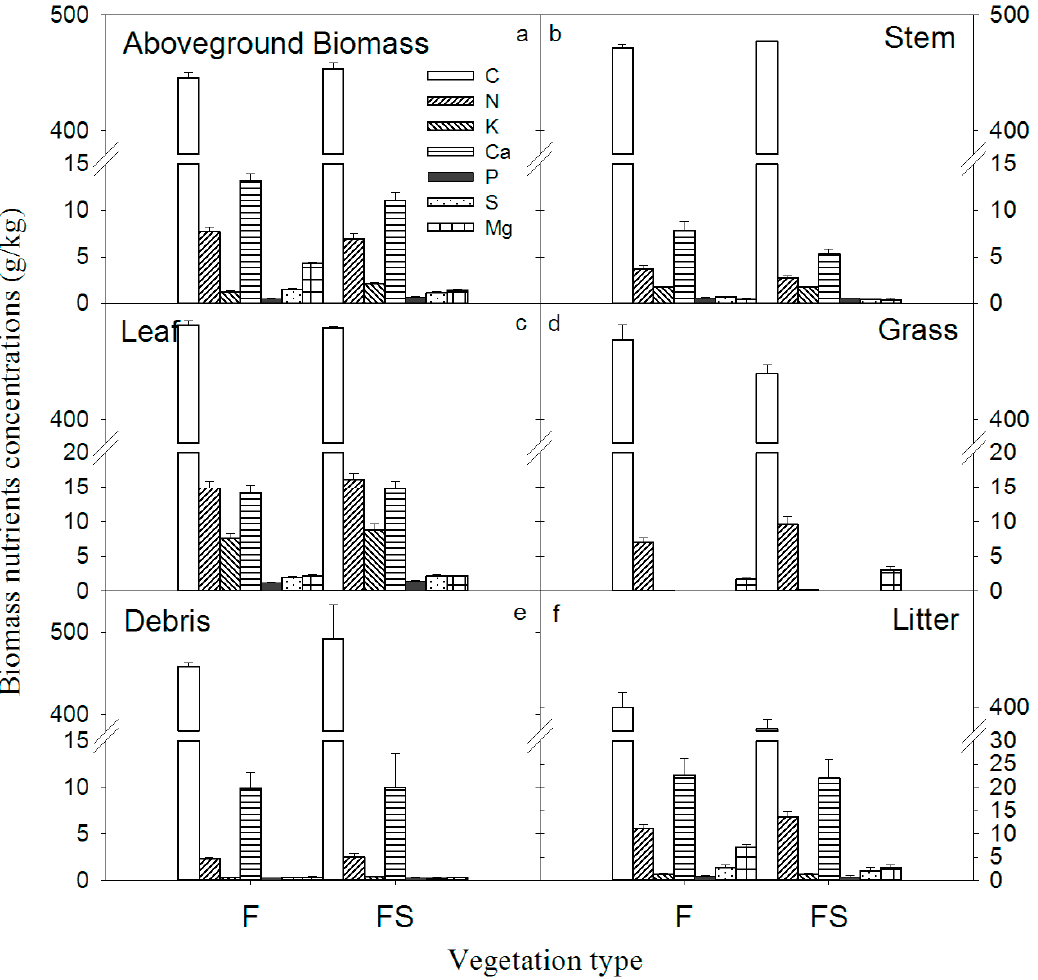
Figure 4. Plant nutrient concentrations of two different vegetation types in southwest China.